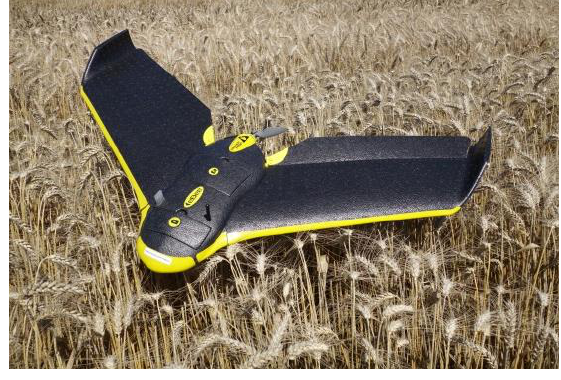
Figure 1. eBee micro UAV by SenseFly Weight (incl. camera)